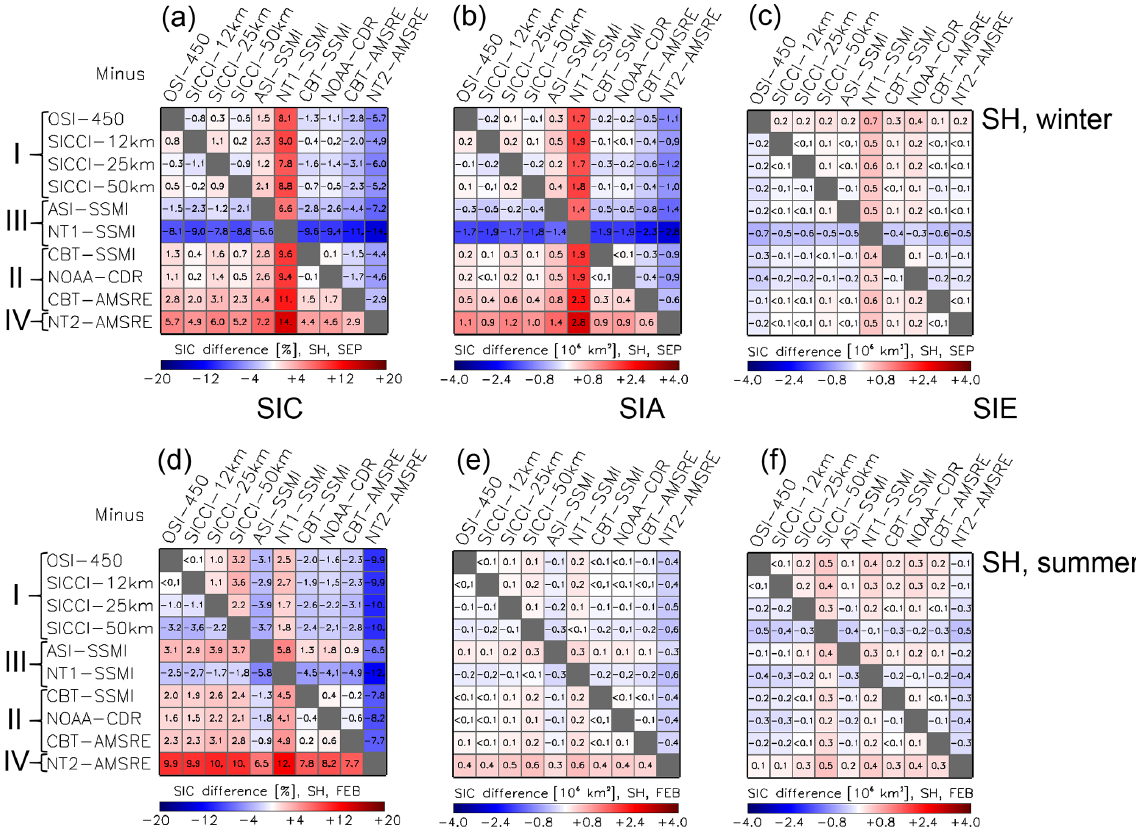
Figure 12. Differences (row minus column) between all 10 products of, from left to right, the average sea-ice concentration SIC, average SIA, and average SIE for the Antarctic (SH) in winter (a–c) and summer (d–f) . The averages are computed from monthly mean values of the respective months (September, February) of the AMSR-E period June 2002 to September 2011. All data are on the EASE-Grid 2.0 with 50km grid resolution. The land mask of the SICCI-50km product is applied to all products. Roman numbers I to IV denote groups according to Table 2. For matrices of all remaining months we refer to Figs. G4–G6 in Appendix